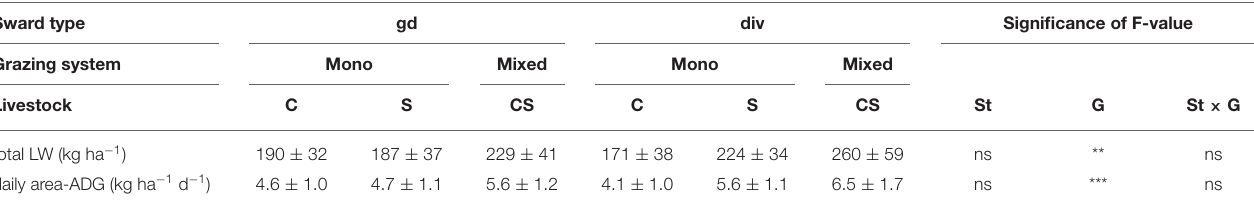
Sward type gd div Significance of F-value Grazing